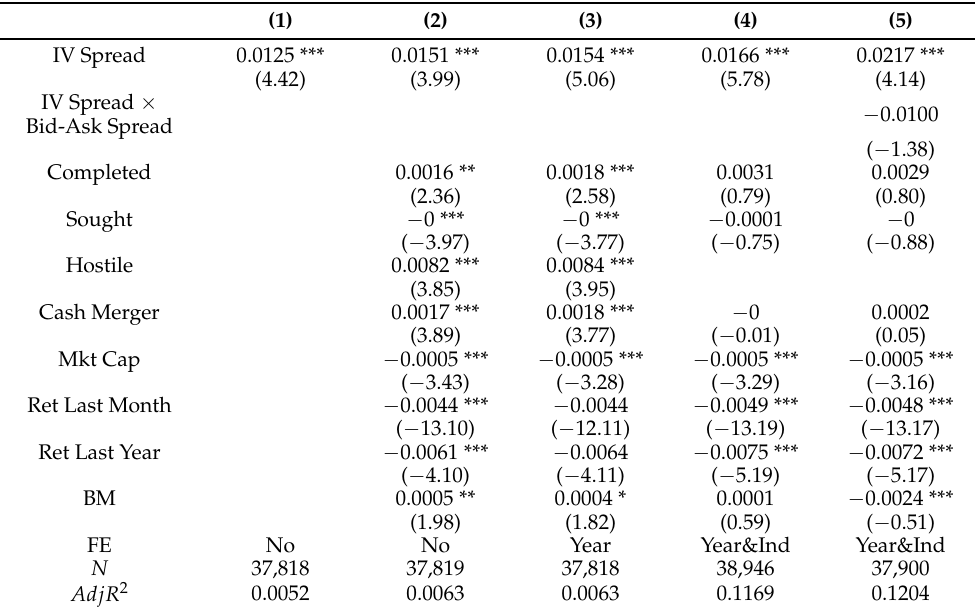
Table 8. Implied Volatility Spread and Target Rival Announcement